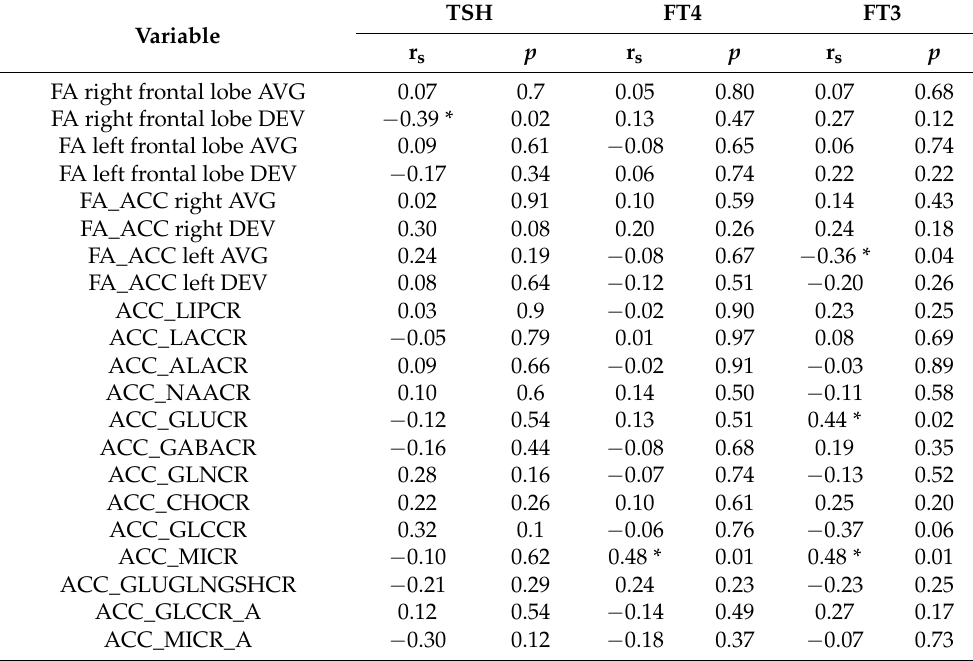
Table 5. Relationship of the thyroid function assessment parameters with the results of specialized imaging